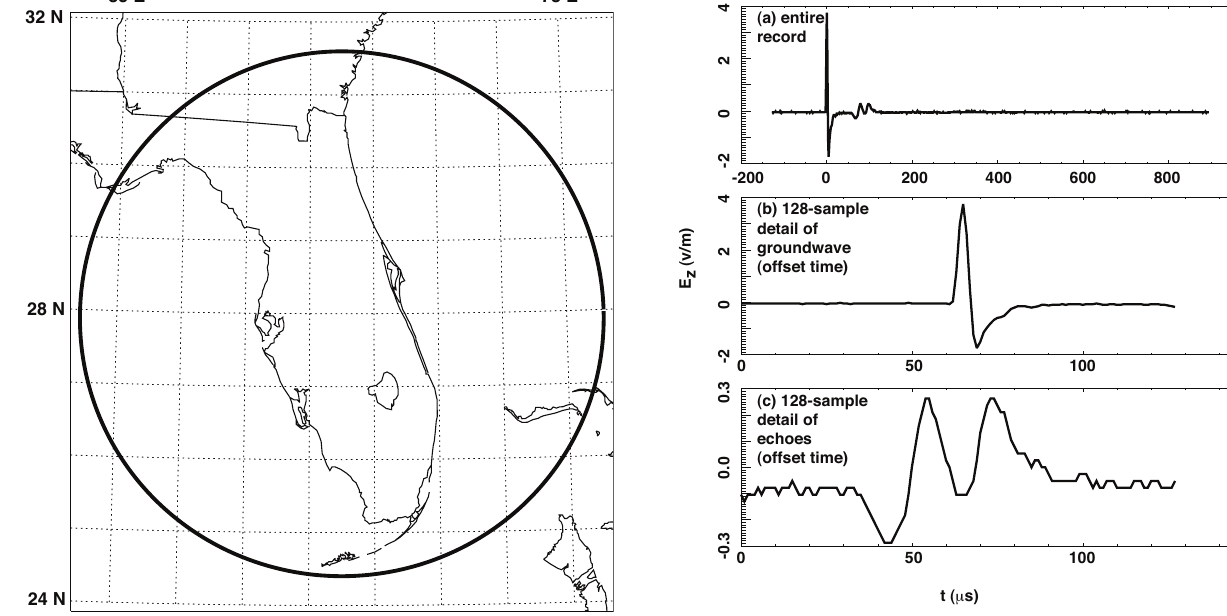
Fig. 2. Florida study area for our data. The circle has radius 400km and is centered on 28 deg N, − 81.5 deg E. Only lightning from within the circle was accepted for analysis.